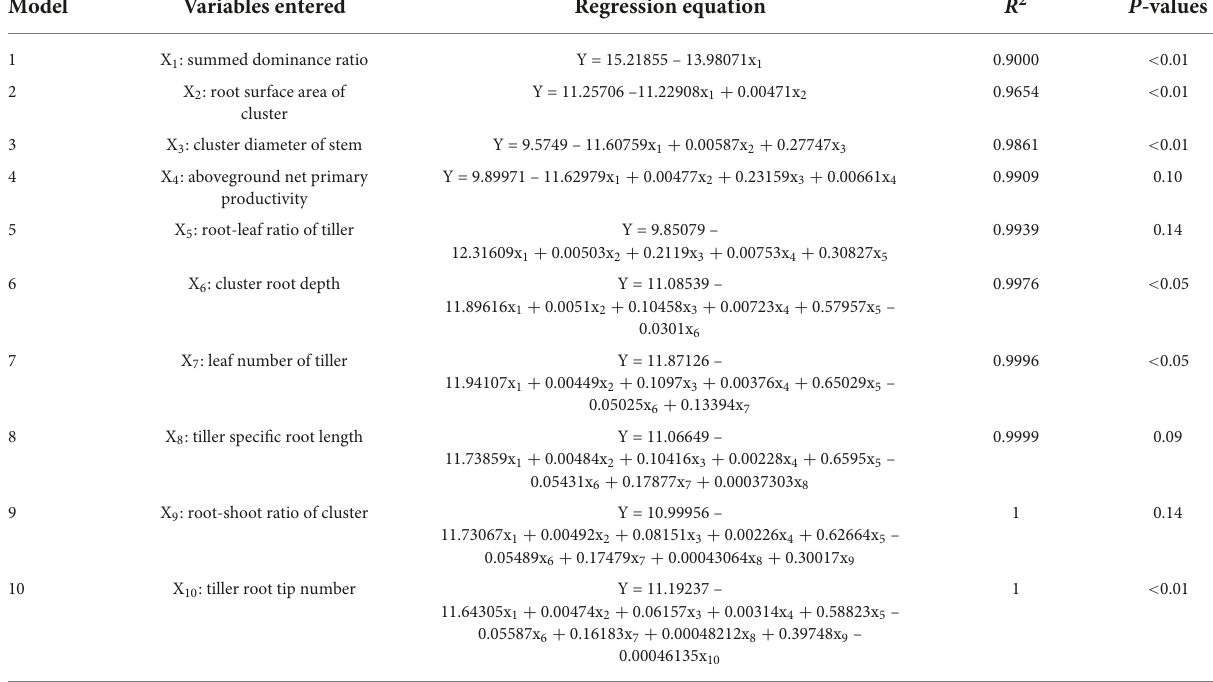
TABLE 2 Results of stepwise regression screening of plant diversity (Y) and Stipa breviflora functional traits. Model Variables